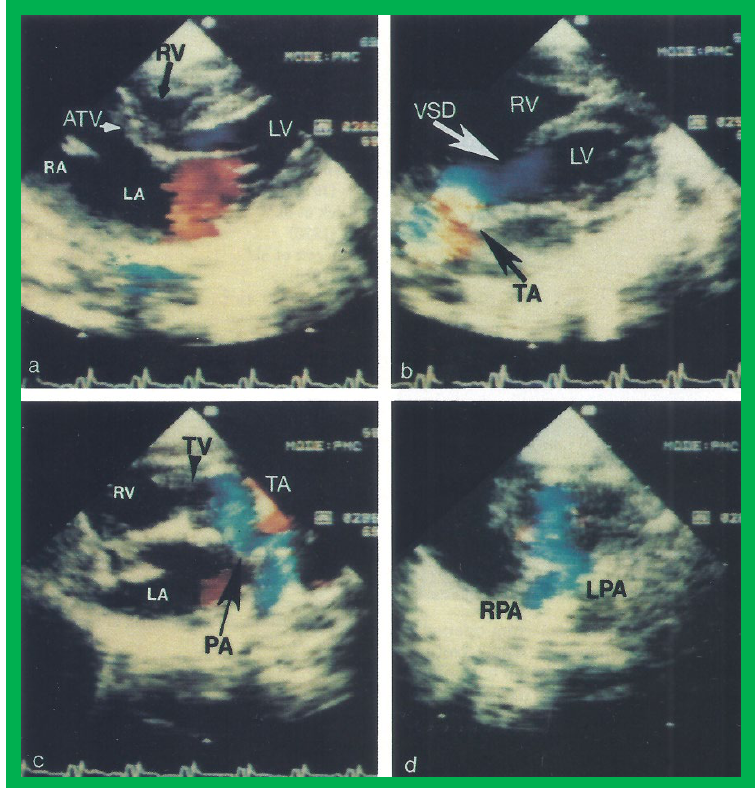
Figure 13. Two dimensional echocardiographic video frames demonstrating ( a ) an atretic tricuspid valve (ATV) between the right atrium (RA) and right ventricle (RV), ( b ) a large subtruncal ventric- ular septal defect (VSD), ( c ) thickened and somewhat domed truncal valve (TV) leaflets, and ( d ) the origin of the pulmonary artery (PA) from the posterior aspect of the truncus arteriosus (TA). LA, left atrium; LV, left ventricle. Reproduced from Rao PS, et al. Am Heart J 1991;122:829-835 [31].